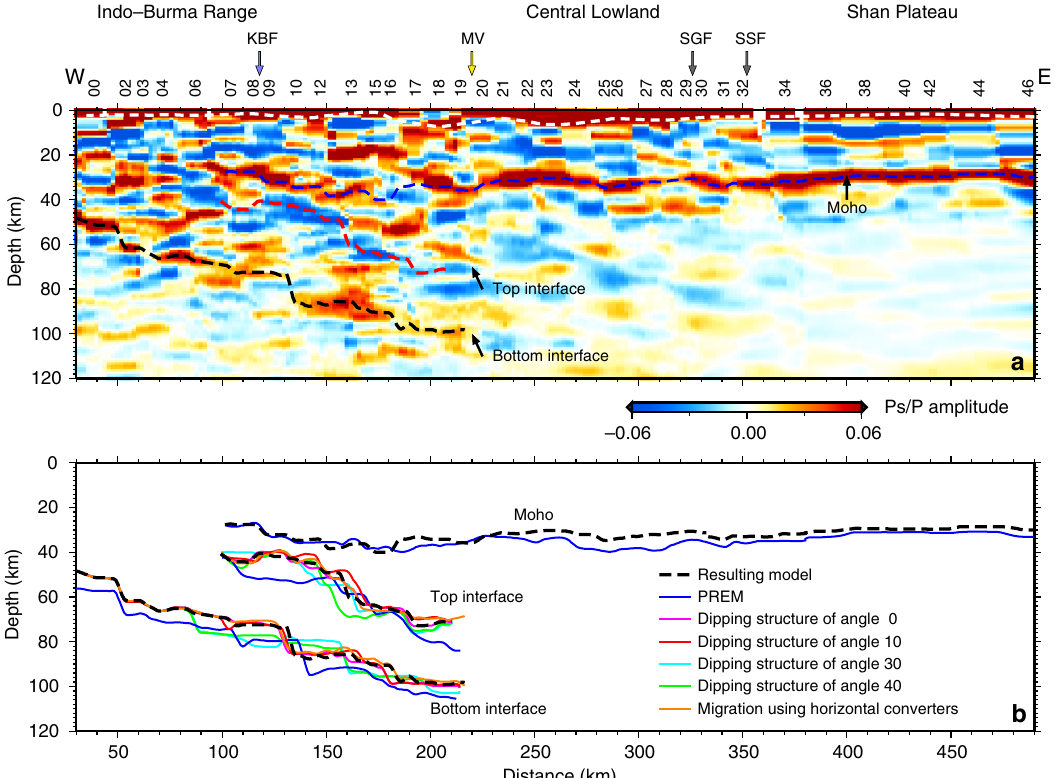
Fig. 4 Resulting common conversion point (CCP) image and reliability analysis. a Resulting CCP image along the seismic pro fi le CMSP. Dashed lines in the CCP image mark the locations of velocity discontinuities, including the basement (white), Moho (blue), top interface (red), and bottom interface (black) of the gently dipping structure. KBF: Kabaw fault; MV: Monywa volcanoes; SGF: Sagaing fault; SSF: Shan Scarp fault. b Comparison of the interface depths identi fi ed from CCP images with different migration models. Various colors mark the interface of the Moho and the top and bottom interfaces of the gently dipping structure obtained from different models. Dashed lines mark the interfaces from the resulting CCP